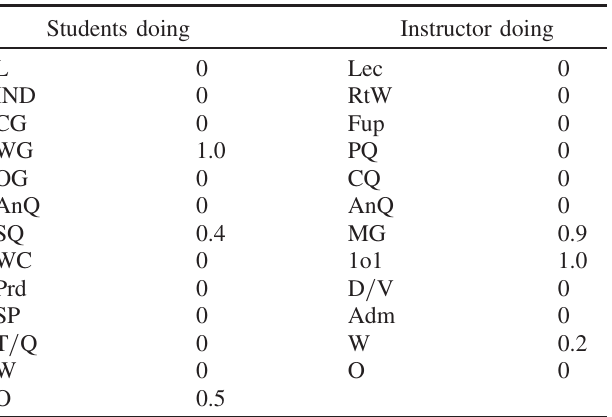
TABLE II. COPUS profile example. The total number of occurrences for each code was tallied in each column, and divided by the number of intervals. For this example, there were 10